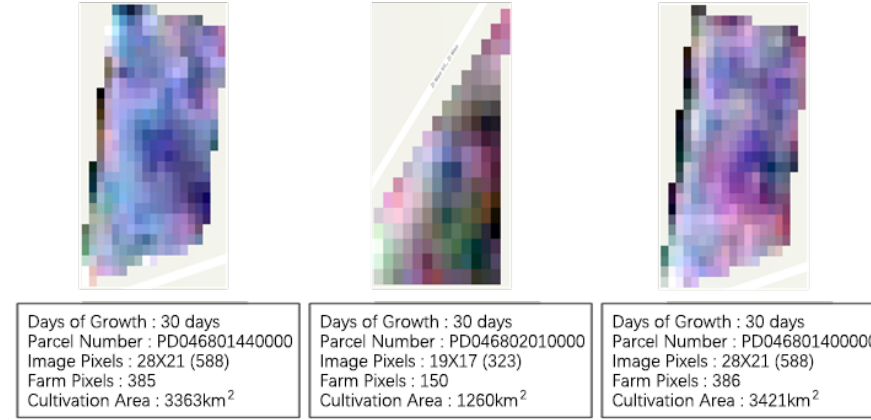
Figure 12. Satellite images of cabbages (10 days).